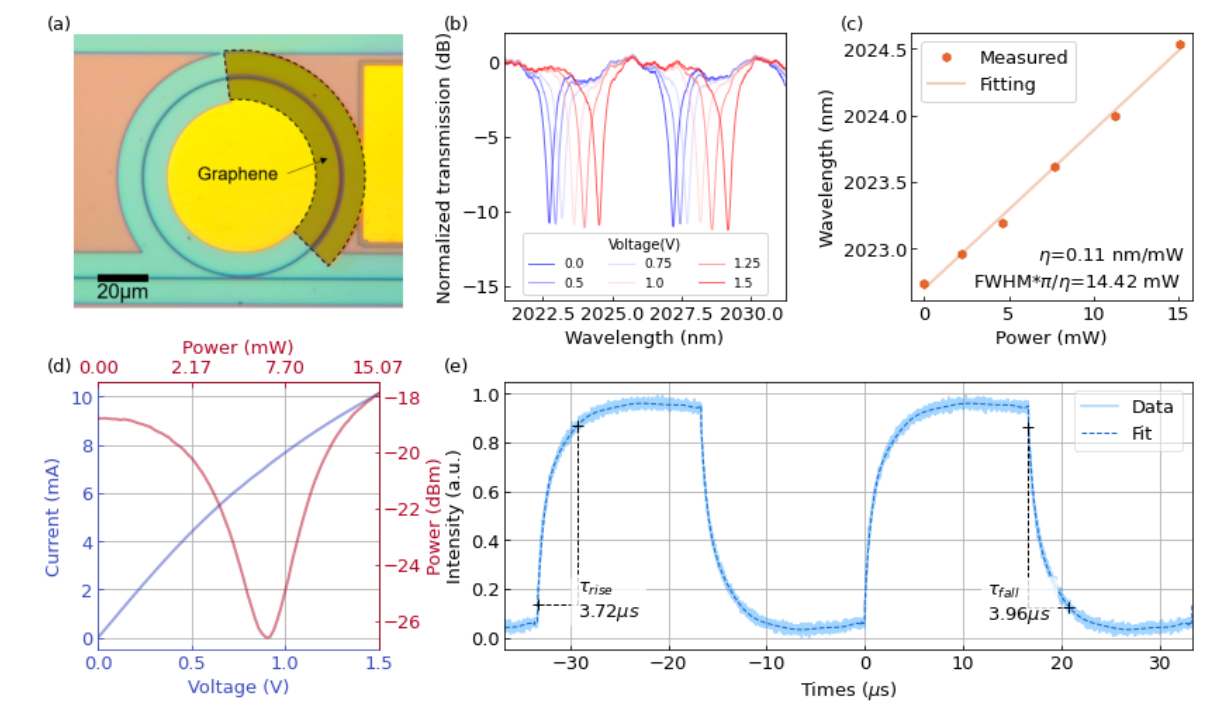
Figure 3. ( a ) Microscope image of an MRR-based graphene TO switch. The graphene is in a fan- shaped area. ( b ) Normalized transmission spectra of the switch under different applied voltages. ( c ) Resonant peak shift of the switch and fitting. ( d ) I-V feature of the graphene heater and O-P curve of the switch. ( e ) Time response of the MRR-based TO switch. Three-dimensional illustration of the MZI-based TO switch with the graphene heater.